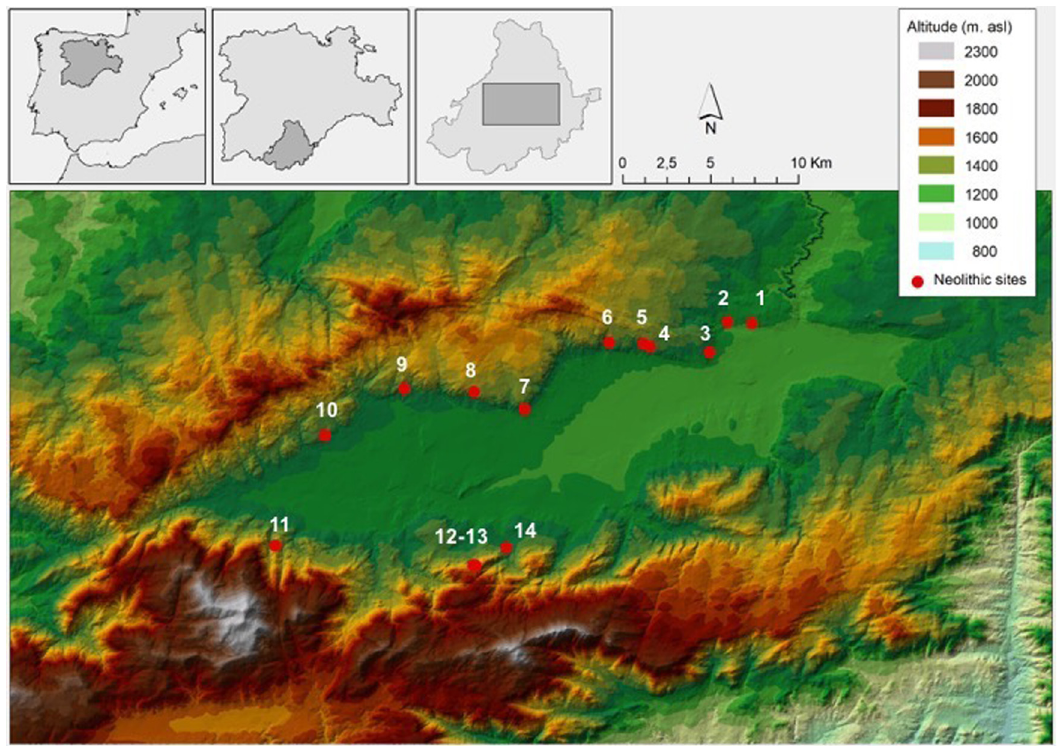
Figure 1: Map showing the location of the Neolithic settlements in the Amblés Valley: ( 1 ) Cerro de la Cabeza; ( 2 ) Cantera de las Hálagas; ( 3 ) Los Berrocales; ( 4 ) Fuente Lirio; ( 5 ) La Atalaya ( Muñopepe ) ; ( 6 ) Dehesa del Pedregal; ( 7 ) La Peña del Águila; ( 8 ) Los Itueros; ( 9 ) El Picuezo; ( 10 ) Las Zorreras; ( 11 ) Canchera Alta I; ( 12 ) Cueva de los Moros; ( 13 ) Umbría de Robledillo; and ( 14 ) La Atalaya ( Solosancho )